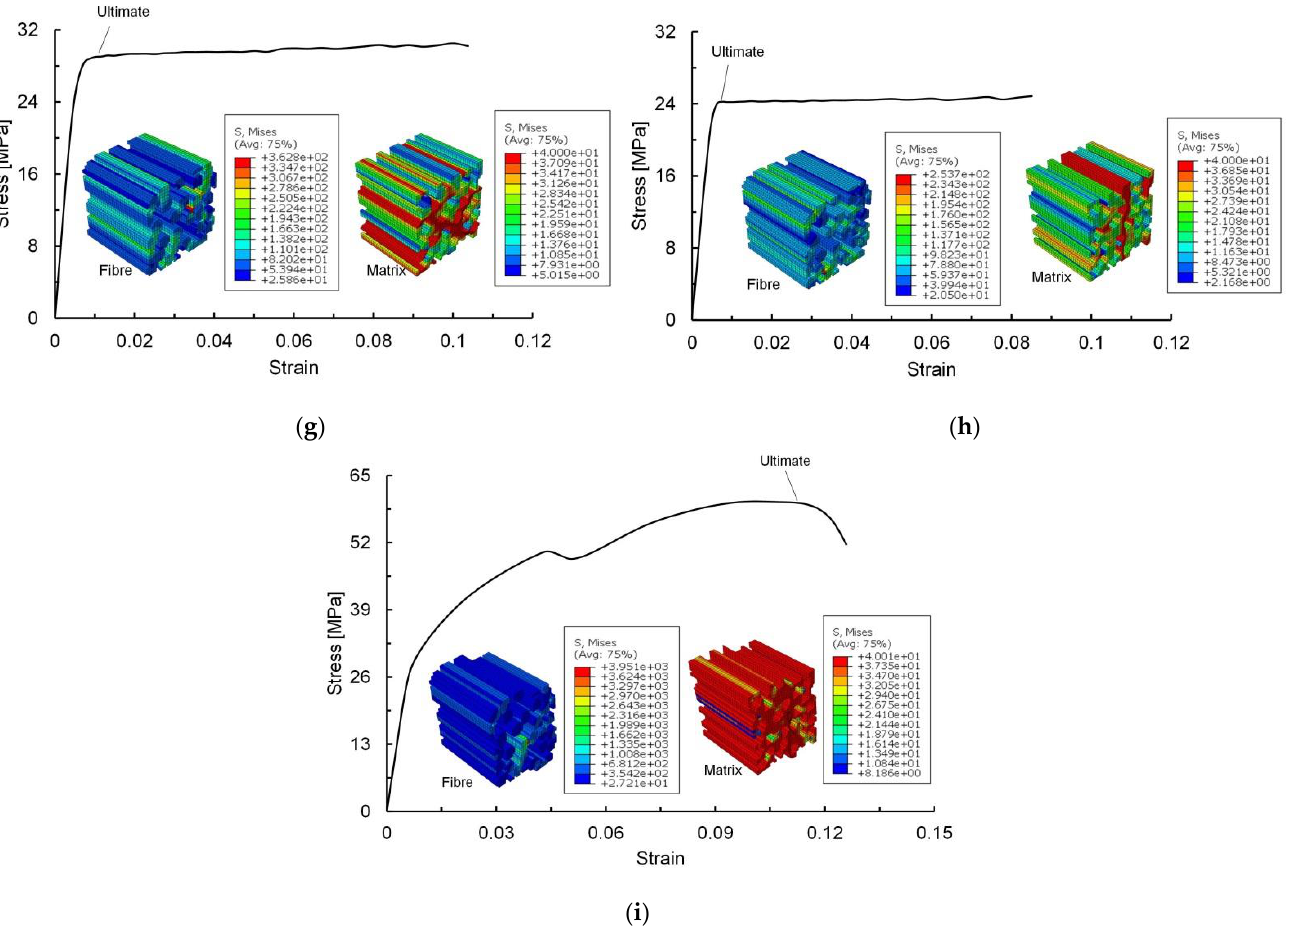
Figure 6. Equivalent stress-strain curves and von Mises stress plots of micro-scale RVE model of the fibre bundle in CSM under ( a ) X-tension, ( b ) X-compression, ( c ) Y-tension, ( d ) Y-compression, ( e ) Z-tension, ( f ) Z-compression, ( g ) XY-shear, ( h ) XZ-shear, and ( i ) YZ-shear.